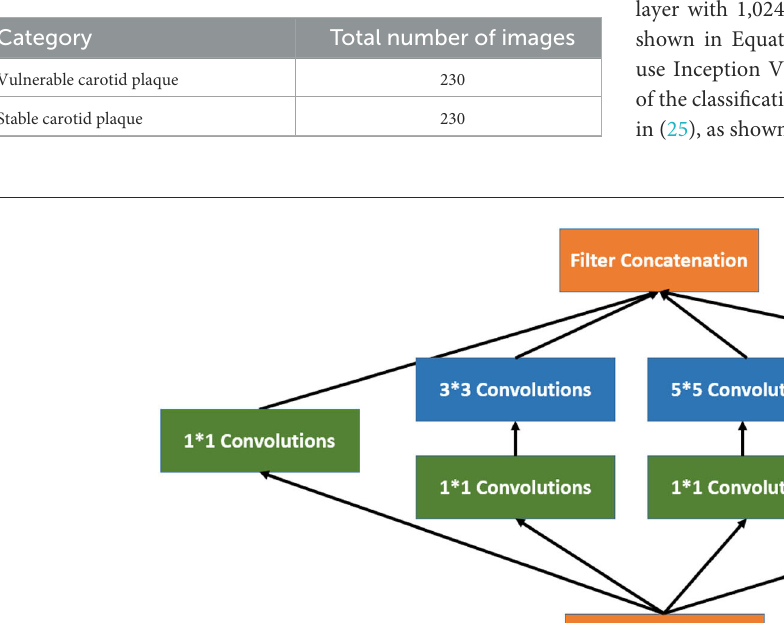
TABLE 1 Statistics of our dataset in each category.